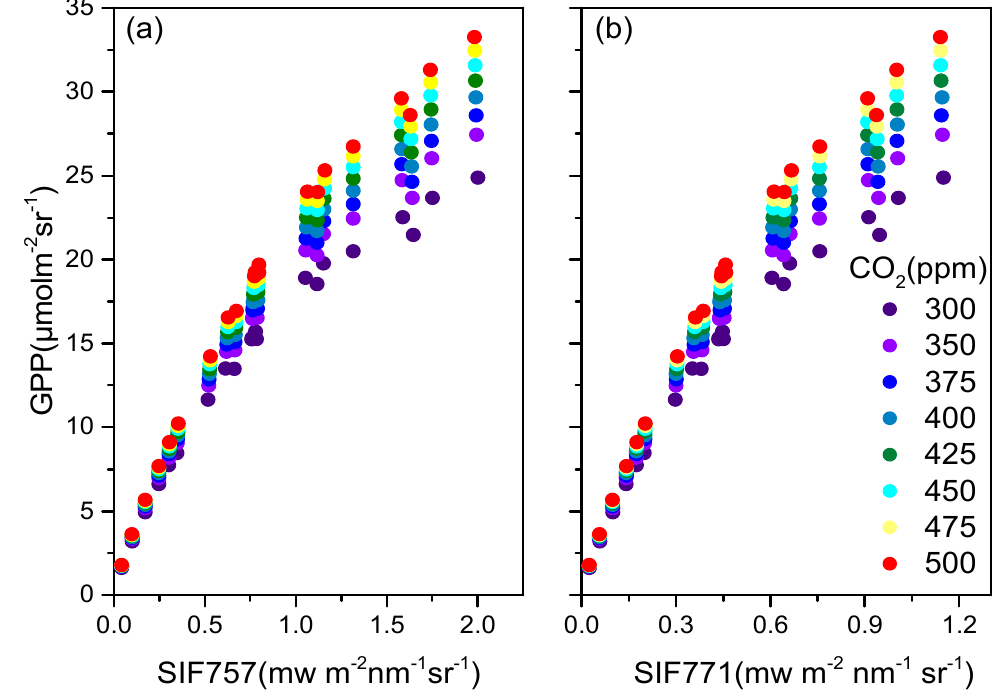
Figure 8. Sensitivity analysis of the effects of different levels of atmospheric CO 2 concentrations on SIF-GPP relationship. (a) SIF757 versus GPP; (b) SIF771 versus GPP.